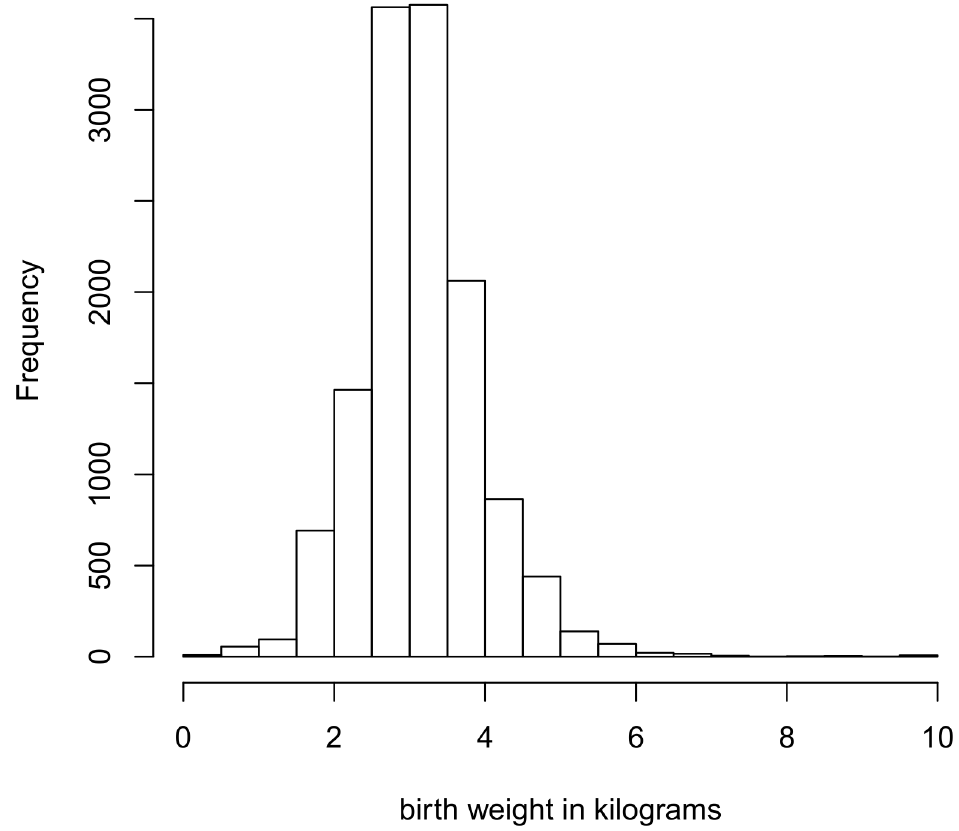
Fig 1. Histogram of child birth weight in